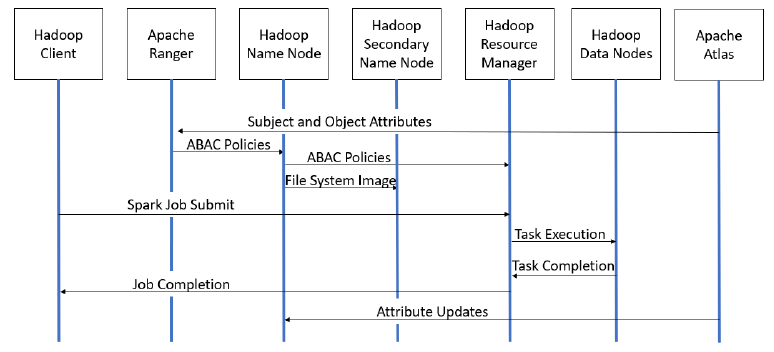
Figure 7. The sequence of attribute information exchange in job Figure 7. The s equence of attribute information exchange in job execution. Apache Ranger